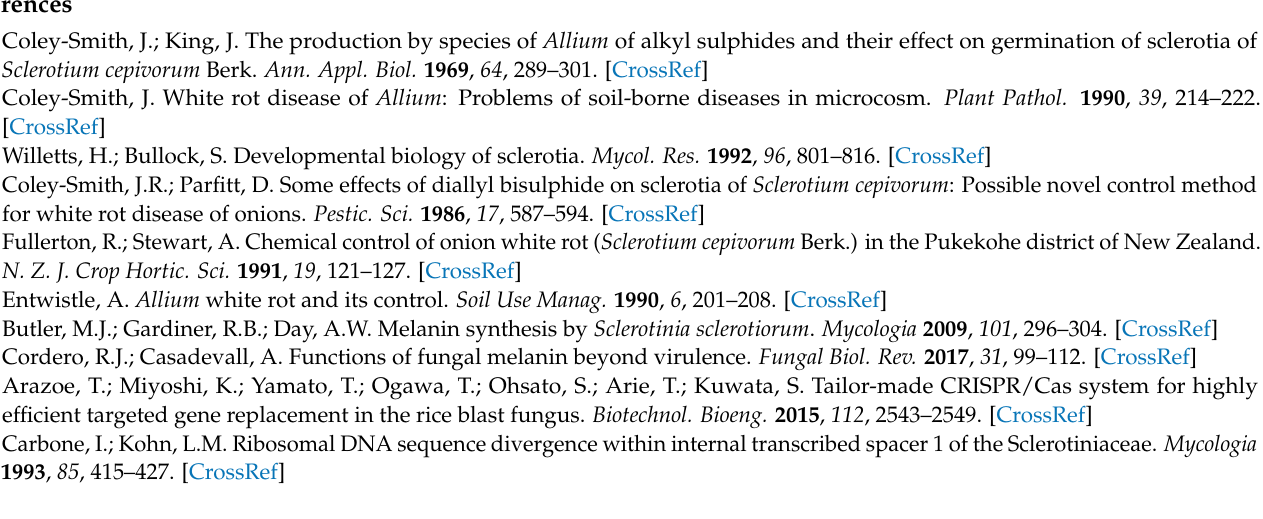
Supplementary Figure S3. Ethyl 2-hydroxy-2-(trifluoromethyl)-2H-chromene-3-carboxylate HMQS spectrum of 2D-NMR (CDCl3). Supplementary Figure S4. Sclerotinia sclerotiorum alignment. Com- parison between SDH of Sclerotinia sclerotiorum (Sequence ID: EDN98455.1) and another SDH of different size. NCBI alignment. Supplementary Figure S5. Multiple alignment of the Scytalone dehy- dratase gene from Sclerotium cepivorum in Gene Bank; NGKD01000004.1 genome sequenced by Kohn., RCTD01000004.1 genome sequenced by Valero-Jimenez et al. [63] and MK965546.1 complete SDH cds. Supplementary Figure S6. Distance tree SDH of S. cepivorum UGTO-Sc1 (GenBank: MK965546.1) [64]. Supplementary Figure S7. Phylogenetic tree of S. cepivorum UGTO-Sc1 SDH [65–71]. Supplementary Figure S8. Sclerotinia sclerotiorum alignment. Comparison between SDH of Sclerotinia sclerotiorum (Sequence ID: EDN98455.1) and another SDH of different size. NCBI alignment. Supplementary Table S1. Primers used for the expression of the SDH heterologous protein. Expression performed in Pichia pastoris by using a pPICZ α plasmid (Invitrogen TM